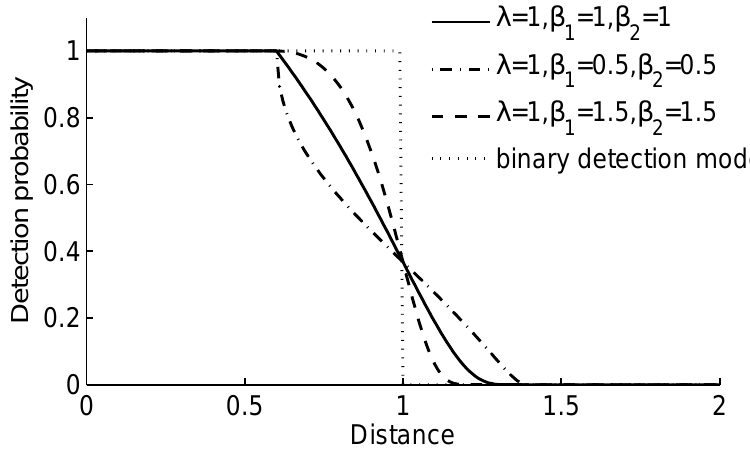
Figure 1. Sensor node detection model with different